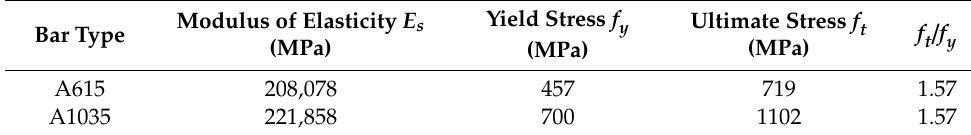
Table 1. Rebar average test data (Adapted from [7]).